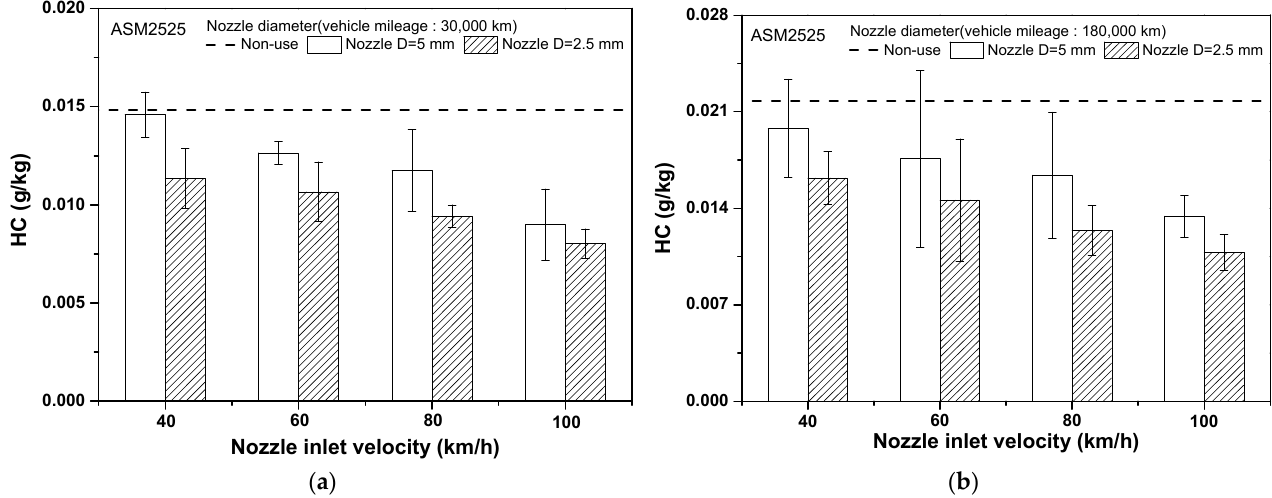
Figure 8 . Variation in HC according to nozzle diameter for 30,000 and 180,000 km mileage engines: ( a ) 30,000 km engine; ( b ) 180,000 km engine.